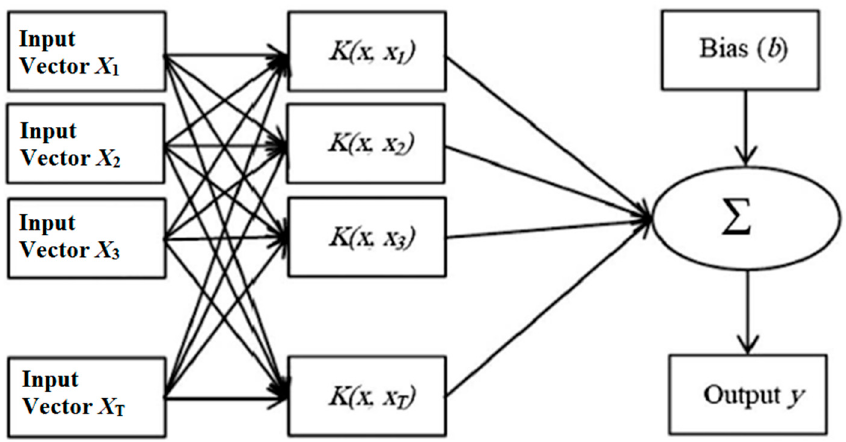
Figure 1. Diagram showing the structure of a typical Least Square Support Vector Machine (LSSVM) model.